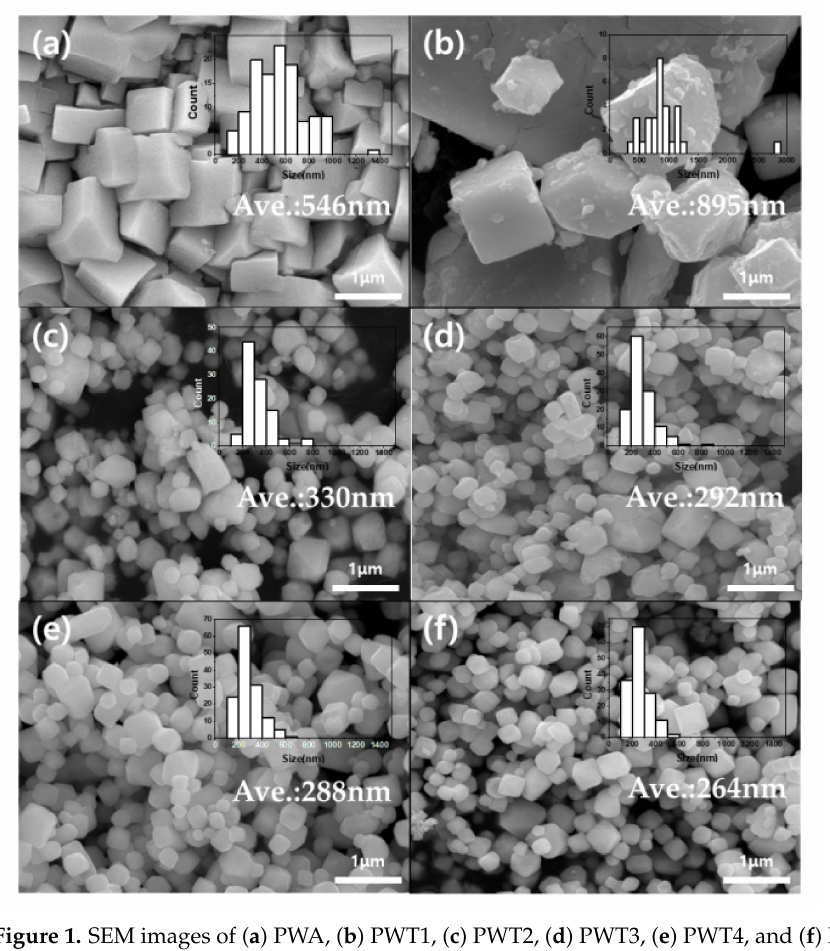
Figure 1. SEM images of ( a ) PWA, ( b ) PWT1, ( c ) PWT2, ( d ) PWT3, ( e ) PWT4, and ( f ) PWT5.